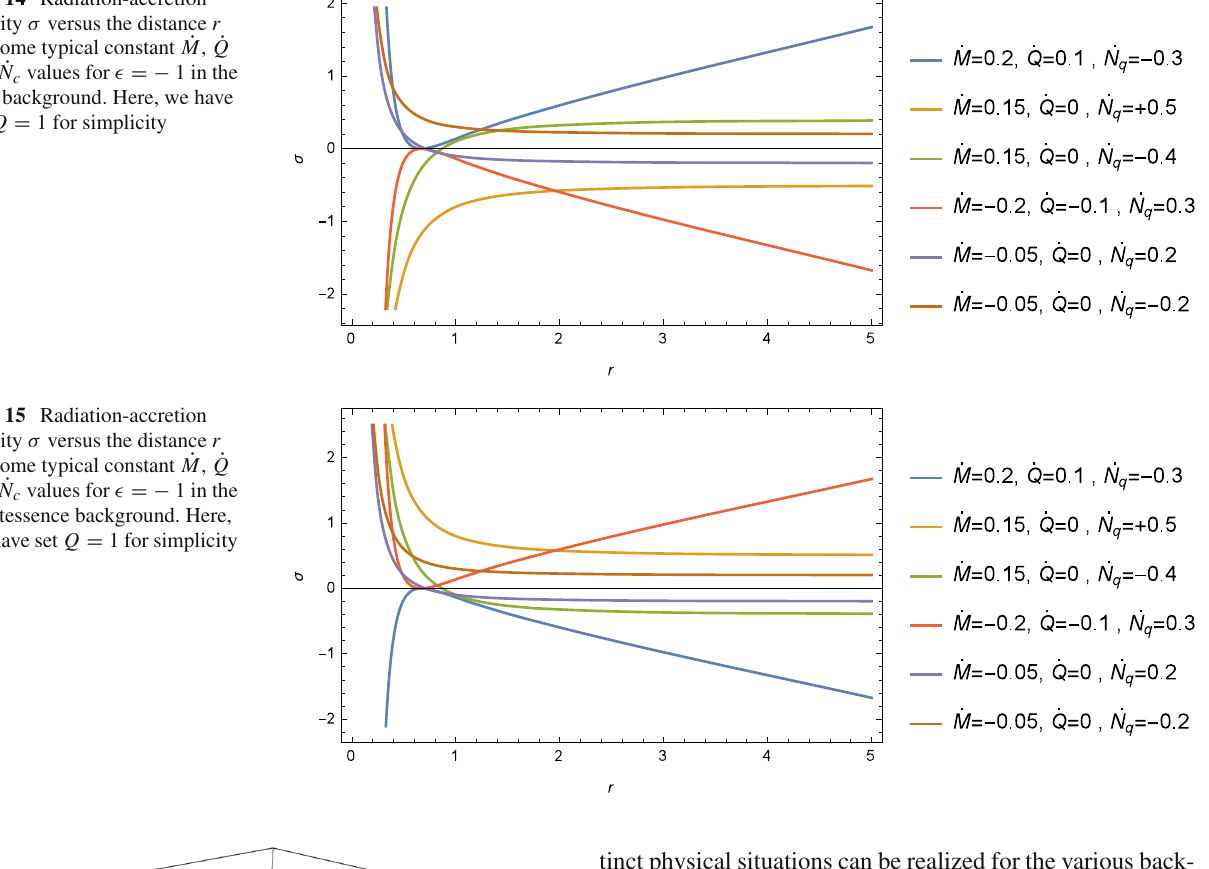
Fig. 14 Radiation-accretion density σ versus the distance r for some typical constant ˙ M , ˙ Q and ˙ N c values for (cid:2) = − 1 in the dust background. Here, we have set Q = 1 for simplicity